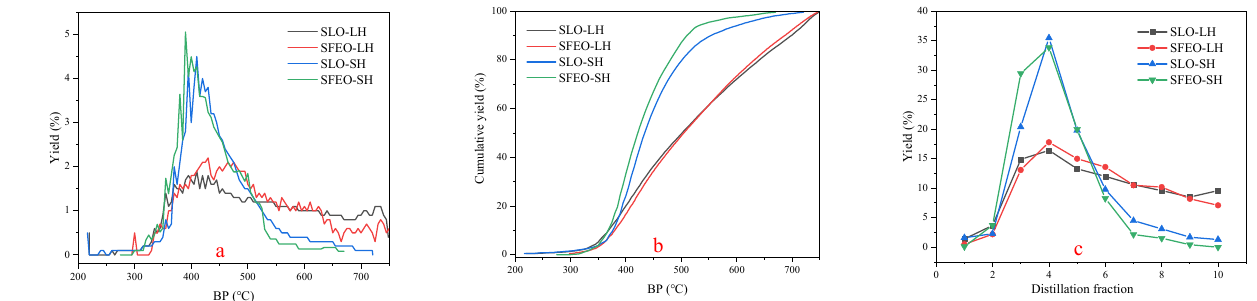
Figure 4. The boiling point distribution of SLO and SFEO (( a ): yield; ( b ): cumulative yield; ( c ): the yield of distillation fraction).